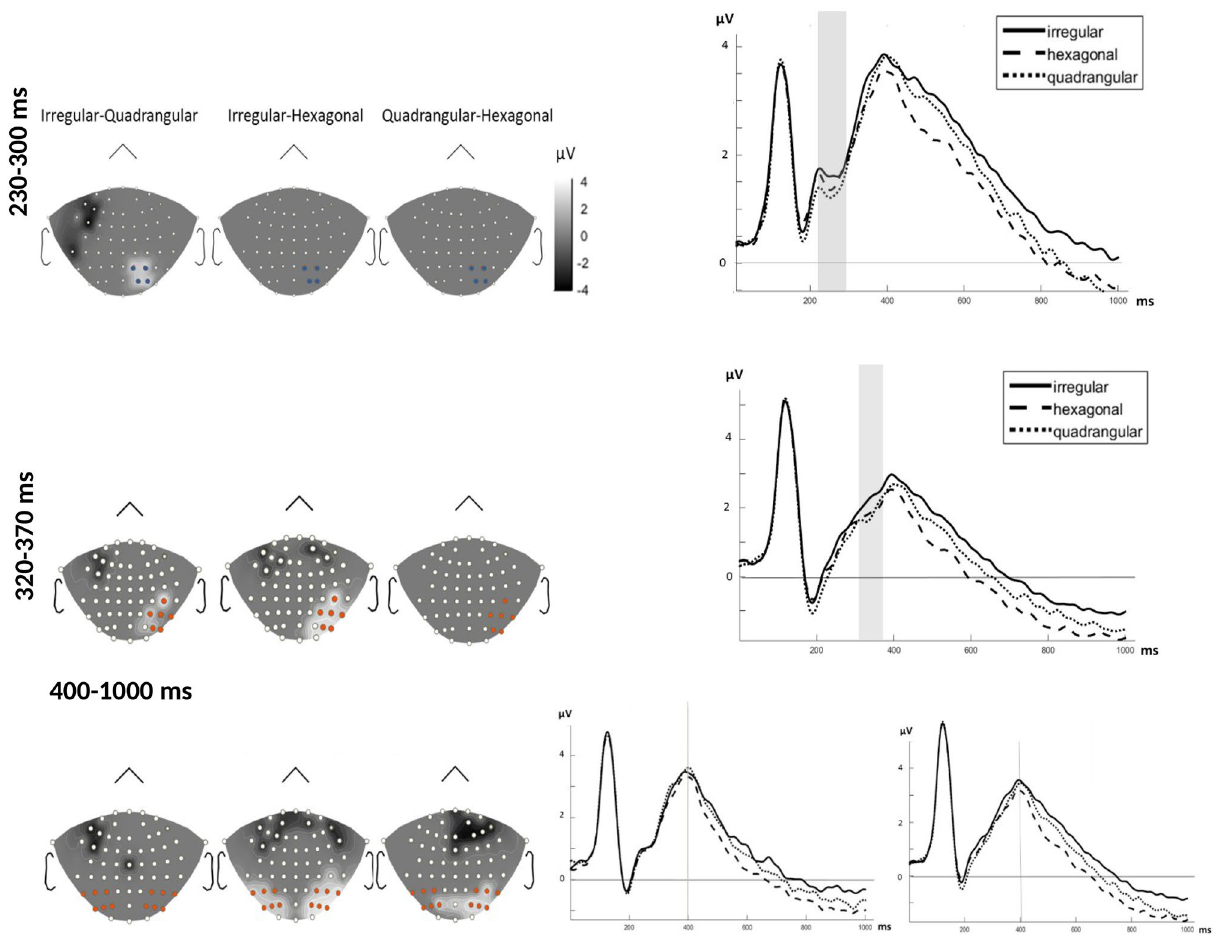
Figure 3. ERP results for different arrangements. Left: Difference topographic plots from the significant time intervals of 230–300 ms (upper panel), 320–370 ms (middle panel) and 400–1000 ms (lower panel) for three arrangement conditions (after FDR correction). Electrodes lied in light area (colored electrodes) entered into the analysis. Right: Time domain ERPs averaged from the electrodes showing the significant arrangement effect. The significant (FDR corrected) time intervals are marked by the shaded area. For lower panel the beginning of the analyzed time window is marked by the vertical line at 400